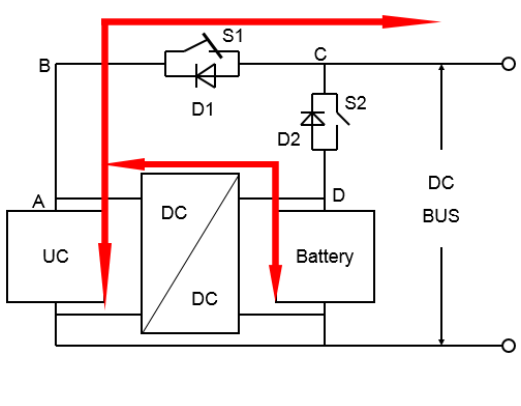
Figure 3. Energy flow in Mode I.